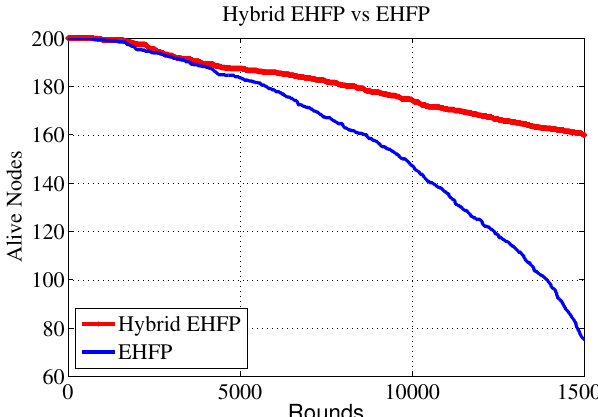
Figure 15. Life time performance of the proposed EHFP with hybrid EH source (solar and